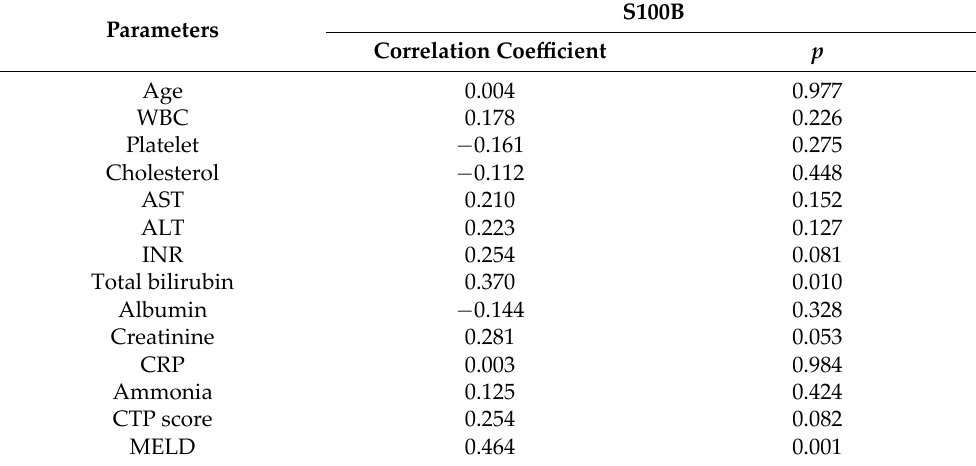
Table 8. Relationships between S100B and clinical parameters in the non‑HE group.